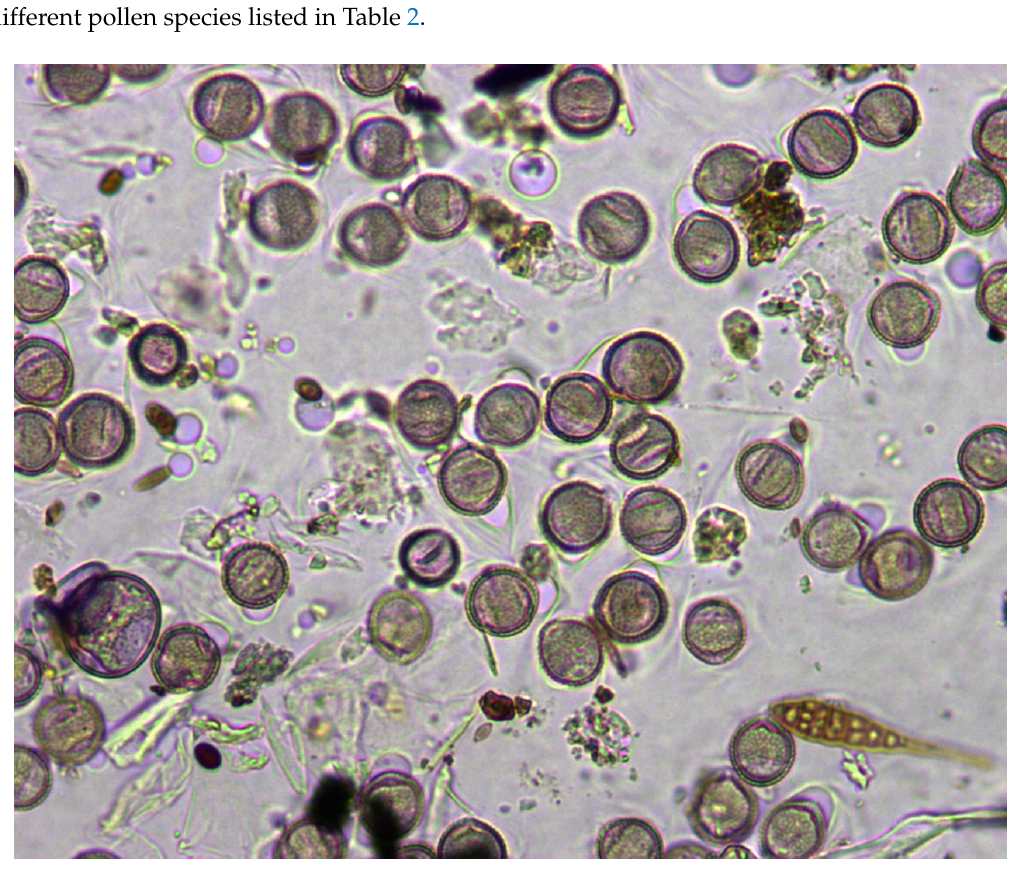
Figure 2. Sample input frame. Observe overlapped and blurred grains in the lower left area. The adhesive residues and tinted bubbles that appear in the background complicate the processing of the